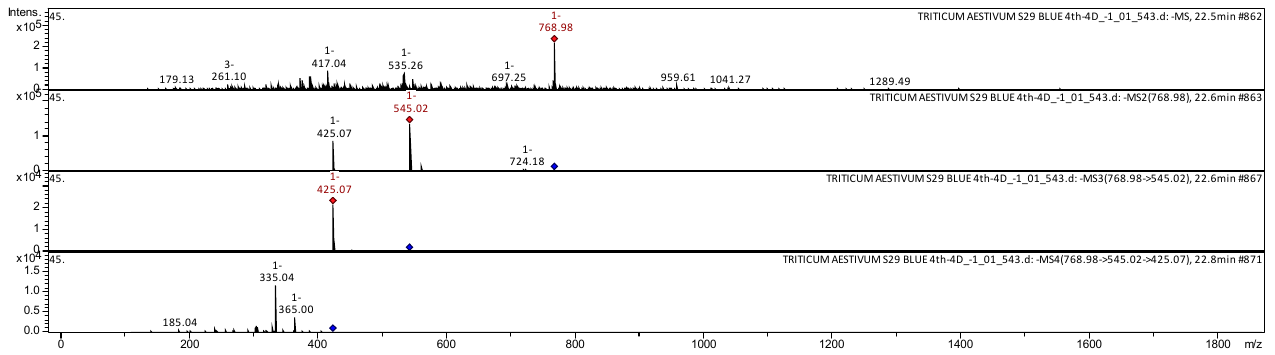
Figure 7. A collision-induced dissociation spectrum of apigenin 2”- O- sinapoyl, C -hexosyl, C -pentosyl from extracts of T.